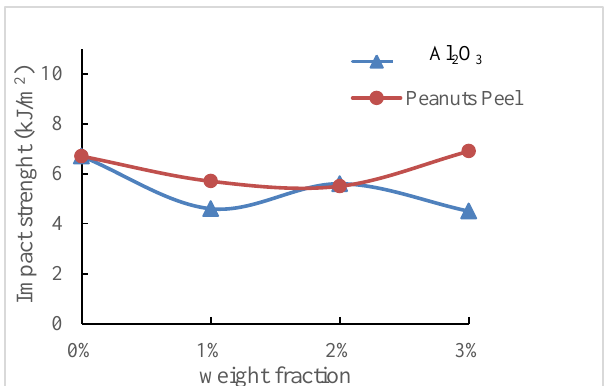
Fig.4: Influence of reinforcement of Pure PMMA with (1%, 2%, and 3%) of Al Peanuts Peel nanoparticles